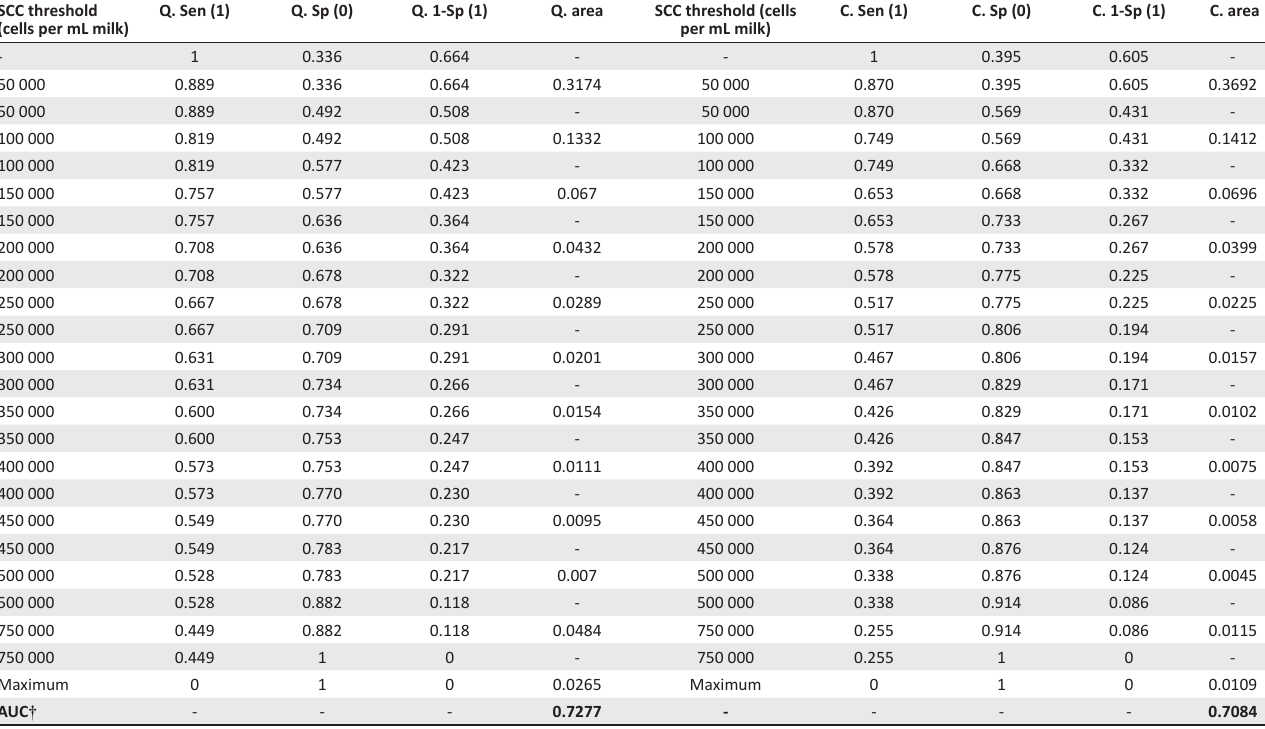
TABLE 5: Receiver operating characteristic curves and area under the curve for the efficacy of somatic cell count test to identify intramammary infection in quarter and composite milk samples. SCC threshold Q. Sen (cells per mL milk)